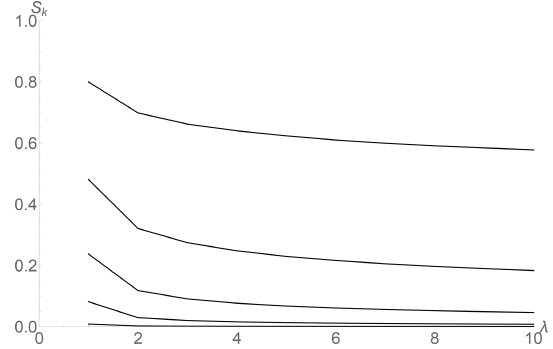
Figure 10. The prediction skill ( S k ) for pure fGn processes for fore- cast horizons up to λ = 10 steps (10 times the resolution). This plot is nondimensional, and it is valid for time steps of any duration. From bottom to top, the curves correspond to h = 1 / 20, 3 / 10, ... 9 / 20 (red, top, close to the empirical h